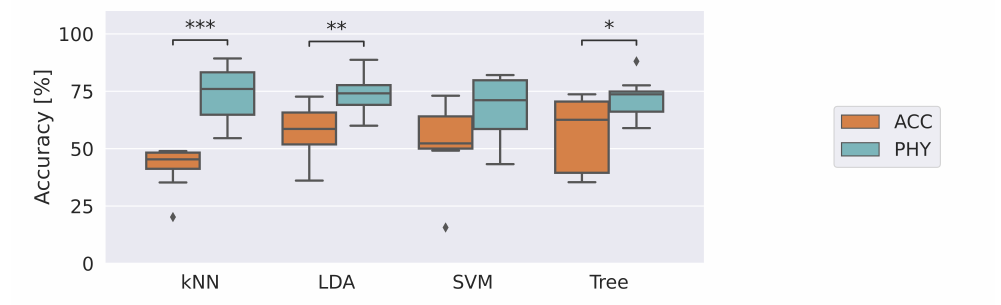
Figure 4. Accuracy returned by the classifiers in identifying risk by using data of accelerations and physiological data, ACC and PHY datasets, respectively. The *, **, and *** denote comparisons in which 0.01 < p -value ≤ 0.05, 0.001 < p -value ≤ 0.01, and p -value ≤ 0.001,